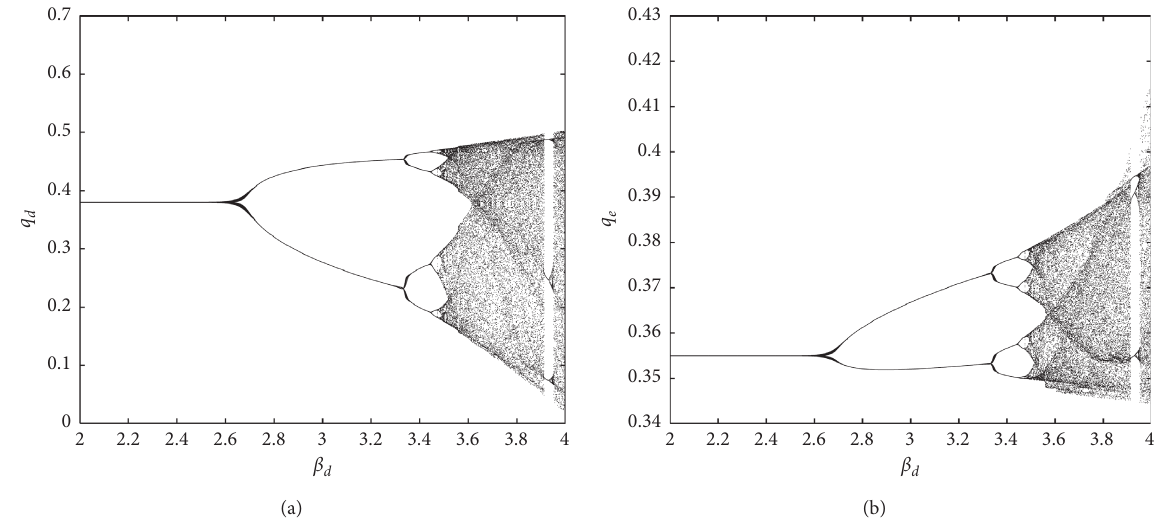
Figure 3: Bifurcation diagrams of q